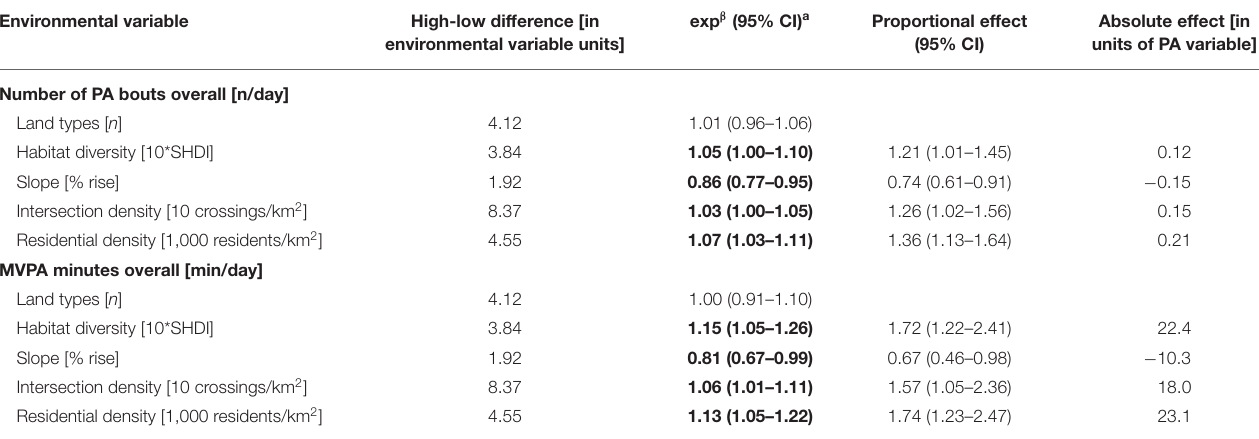
TABLE 4 | Proportional and absolute effects of high-low differences in environmental variables on PA ( n = 167). Environmental